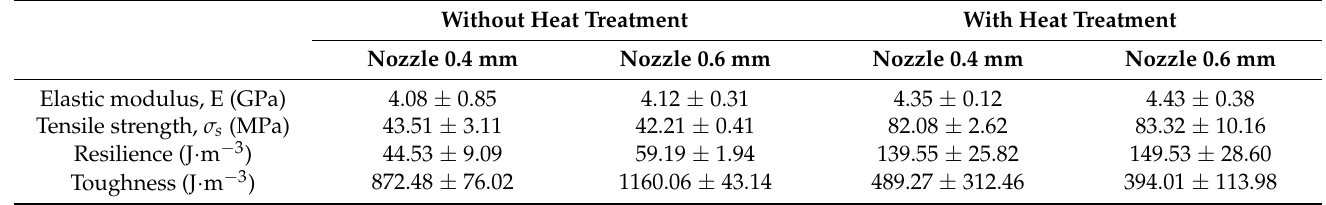
Table 5. Tensile properties of samples of filament extruded with nozzles (0.4 mm and 0.6 mm), with and without heat